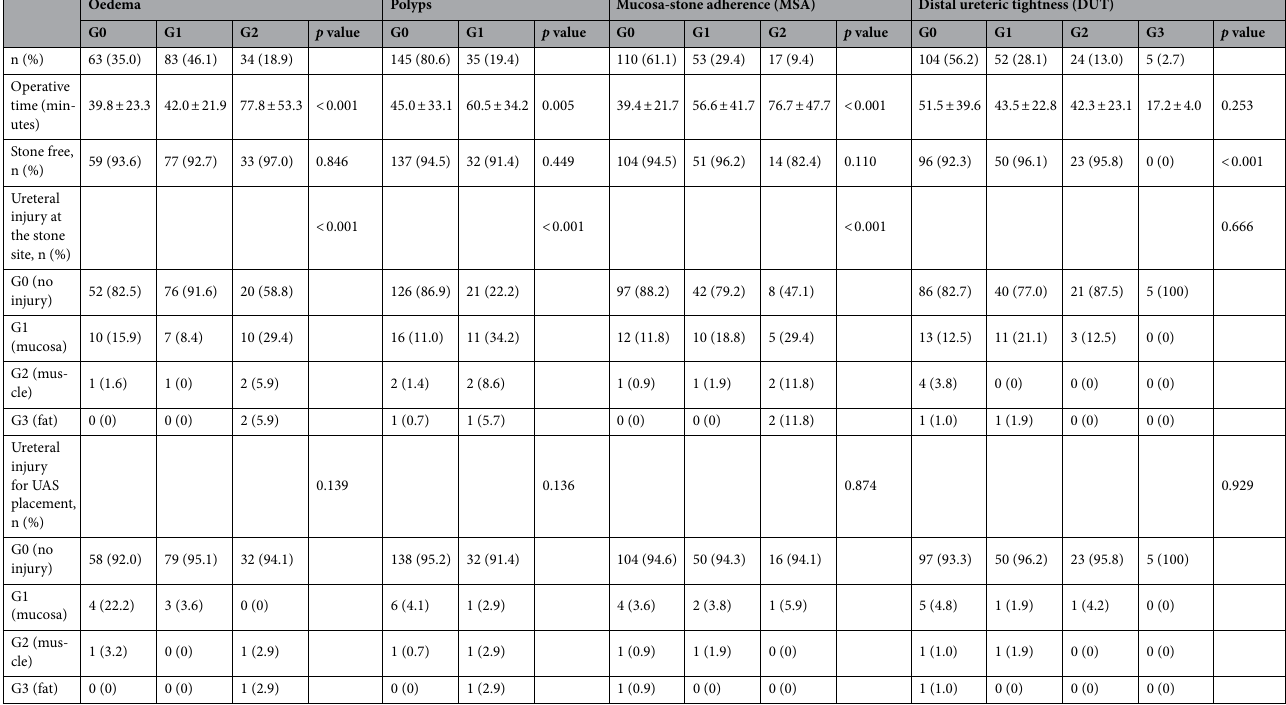
Table 4. Association between surgical outcomes and endoscopic findings. Data are given in means and standard deviations. UAS ureteral access sheath.